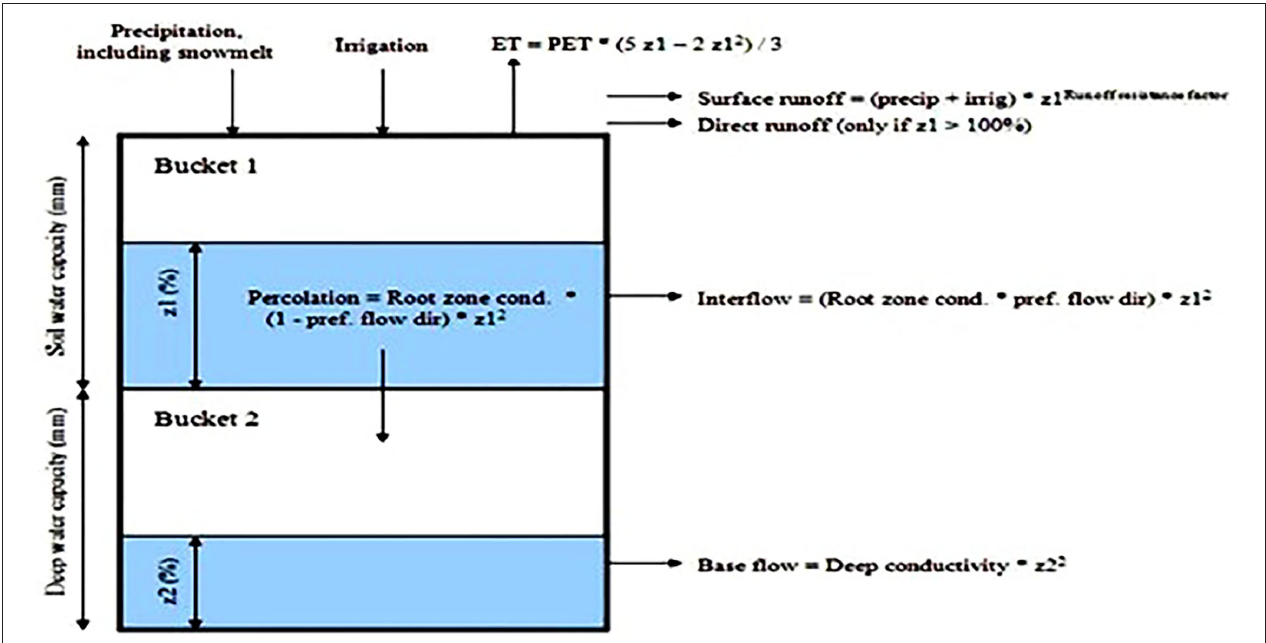
FIGURE 2 | Representation of the soil moisture method and equations (Seiber and Purkey, 2015).